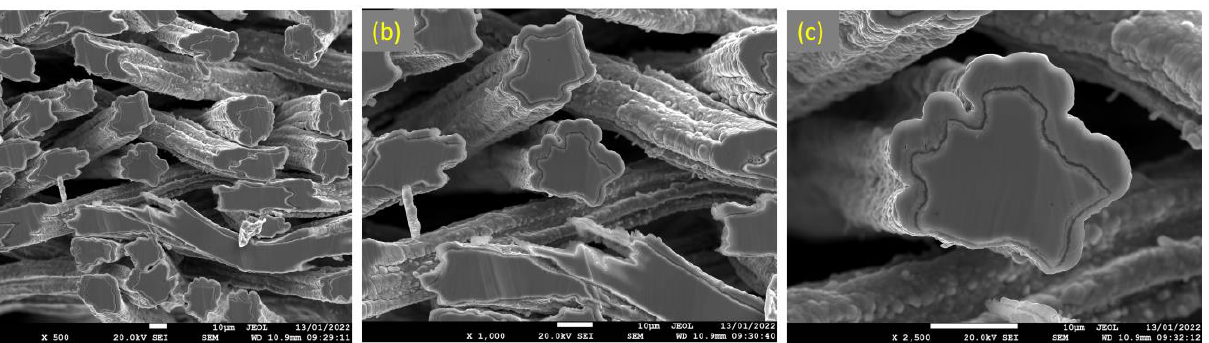
Figure 12. SEM micrographs of a cross-section of 12 µ m FeCrAl fibers, after 18 MSHT cycles, at different magnifications: ( a ) ×500, ( b ) ×1000, and ( c ) ×2500.